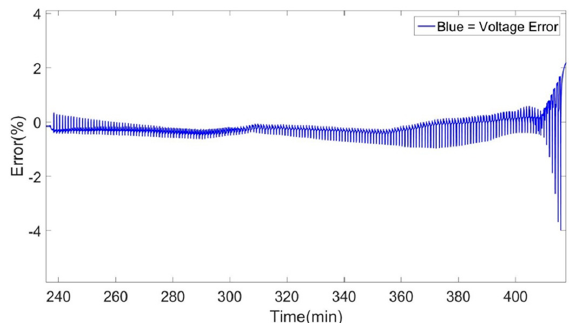
Figure 10. 1st order Thévenin model measured and simulated dynamic discharge pulse (DDP) comparison at 25 °C with Coulomb counting and normal characterization.